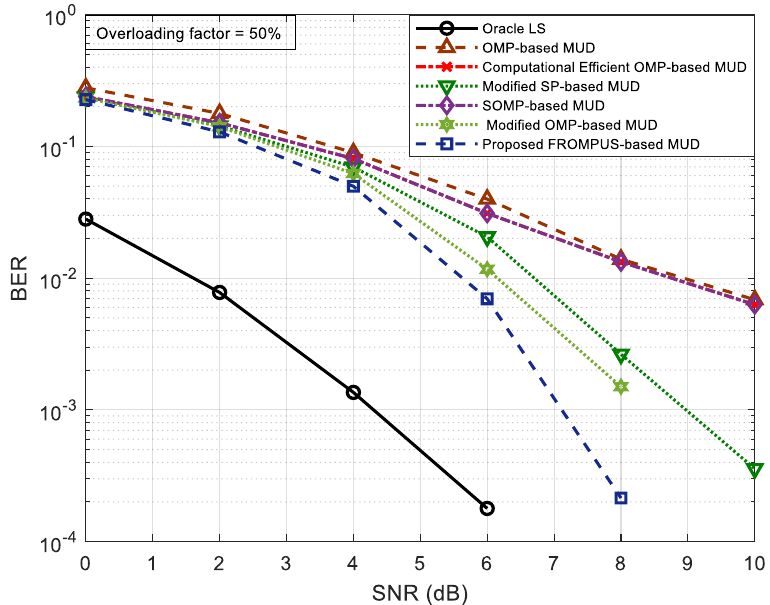
Figure 2. Achievable BER versus SNR performance of the FROMPUS-based MUD in comparison with five other MUDs: overloading factor= 50%, ℑ = 20 , and 𝑇 = 7.